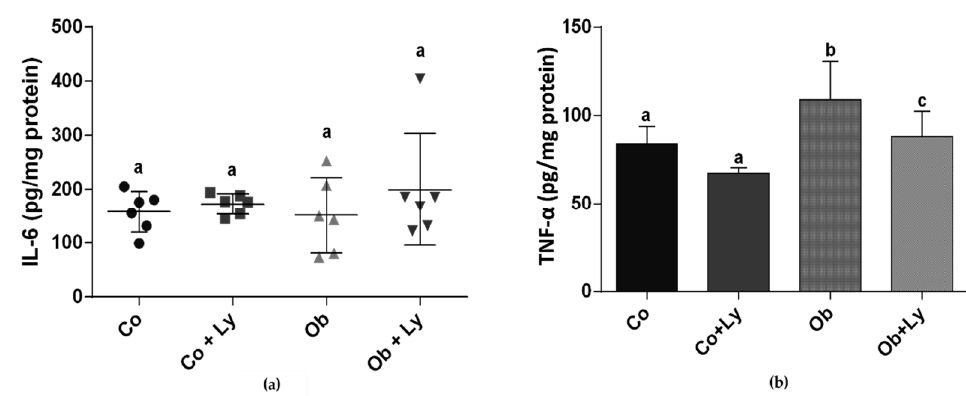
Figure 3. Inflammatory process in hepatic tissue: ( a ) IL-6 (pg / mg protein); ( b ) TNF- α (pg / mg protein). Co: Control group; Co + Ly: Control group supplemented with lycopene; Ob: Obese group; Ob + Ly: Hypercaloric group supplemented with lycopene. Data parametric expressed in mean ± standard deviation. Comparison by two-way ANOVA with Holm-Sidak post-hoc test. Data non-parametric expressed in median and interquartile range. Comparison by Kruskall Wallis test with Tukey post-hoc test. Di ff erent letters correspond to the significant statistical di ff erence ( p < 0.05); n = 6 animals / group. IL-6: Interleukin-6; TNF- α : Tumor necrosis factor- α .